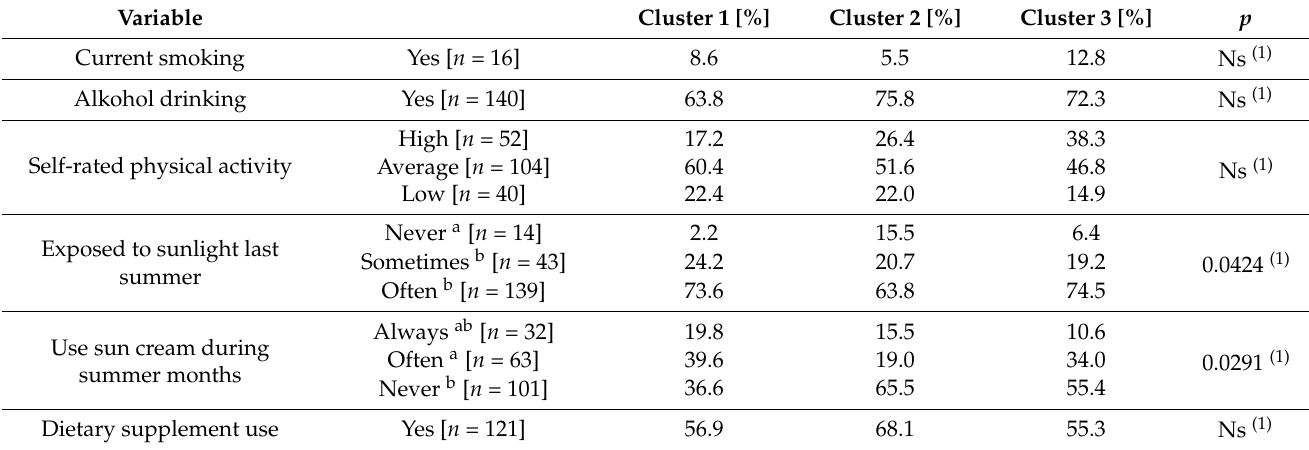
Table 3. Variables of lifestyle and vitamin D intake of the study population by